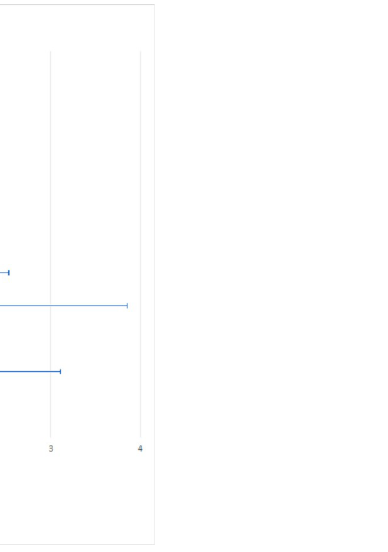
Fig 2. Forest plot of bias corrected relative risk for developing glucose